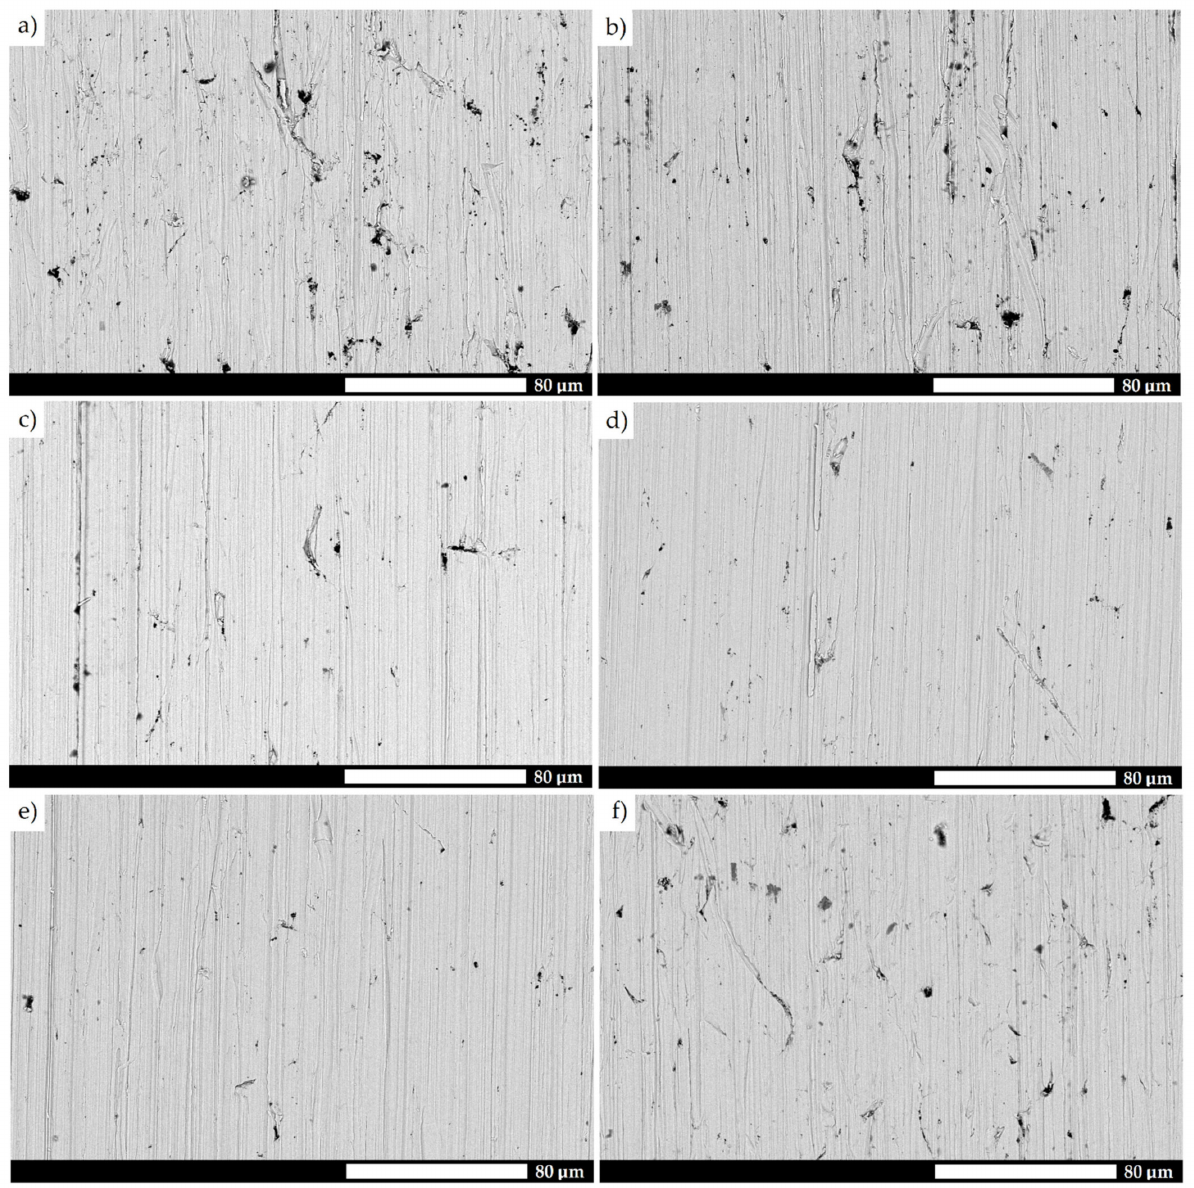
Figure 9. Images of worn surfaces. ( a ) 38GSA (N); ( b ) Creusabro 4800; ( c ) Creusabro 8000; ( d ) TBL PLUS; ( e ) XAR 600; ( f ) 38GSA (HT). SEM,